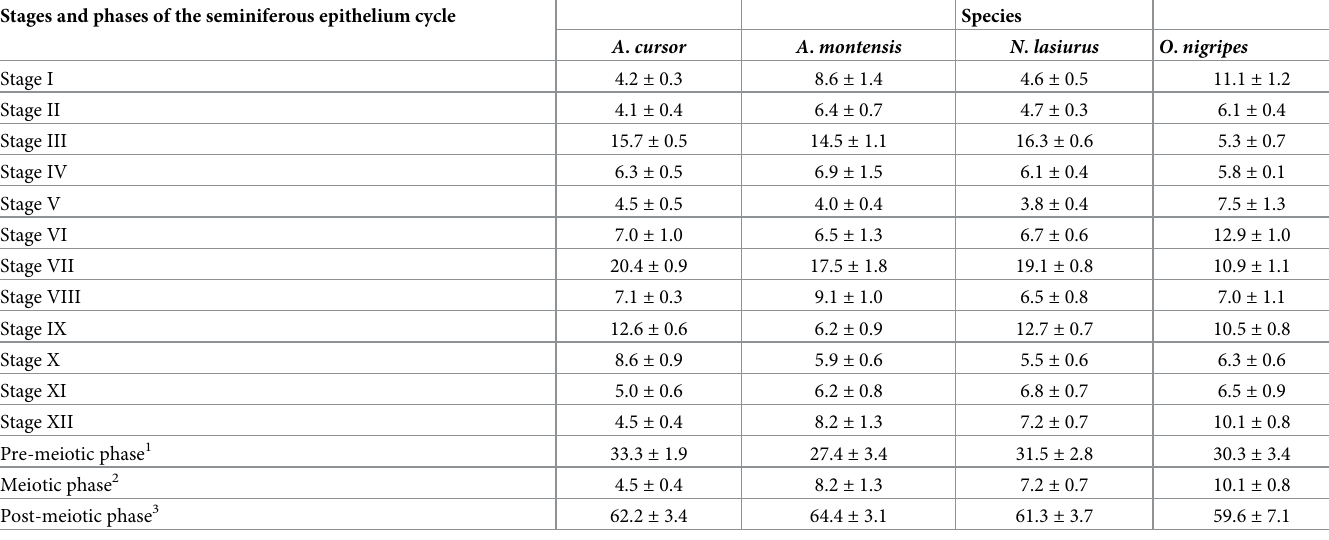
Table 2. Relative frequencies (%) of the stages and phases of the seminiferous epithelium cycle in A . cursor , A . montensis , N . Lasiurus and O . nigripes (mean ± SEM). Stages and phases of the seminiferous epithelium